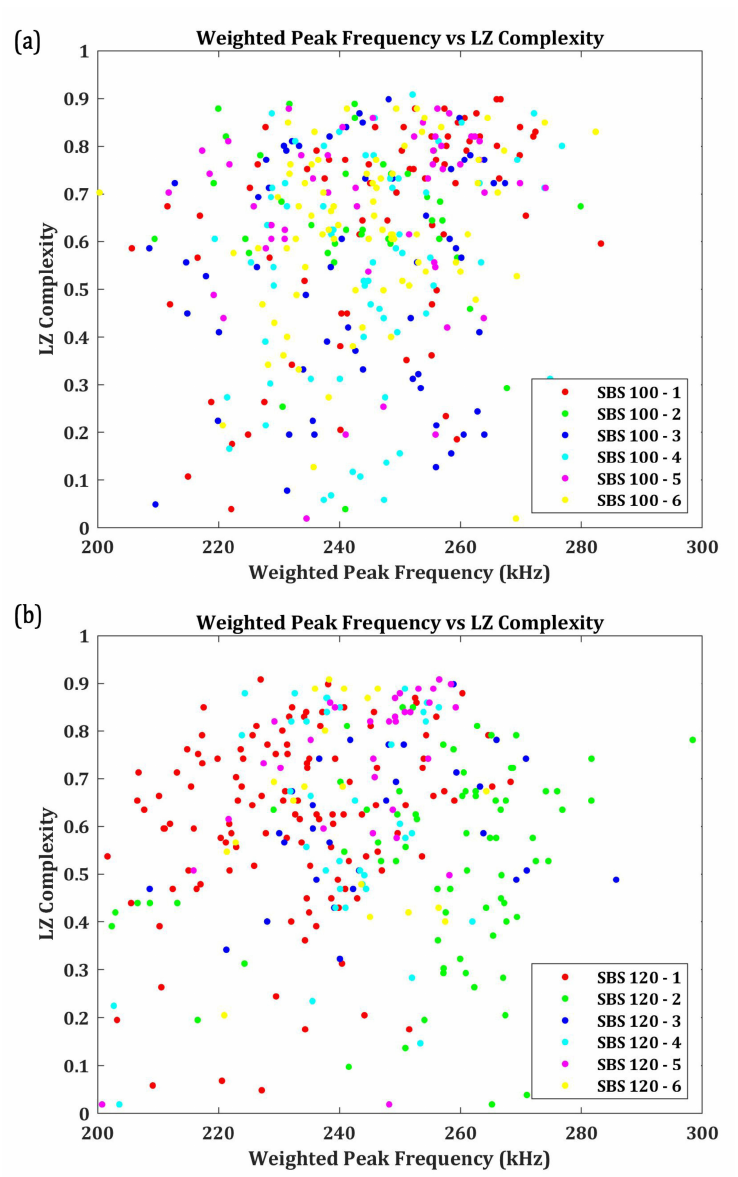
Figure 9. Weighted Peak Frequency (between 200 kHz and 300 kHz) vs. LZ complexity of the AE signals for SBS specimens tested at ( a ) 100 ◦ C and ( b ) 120 ◦